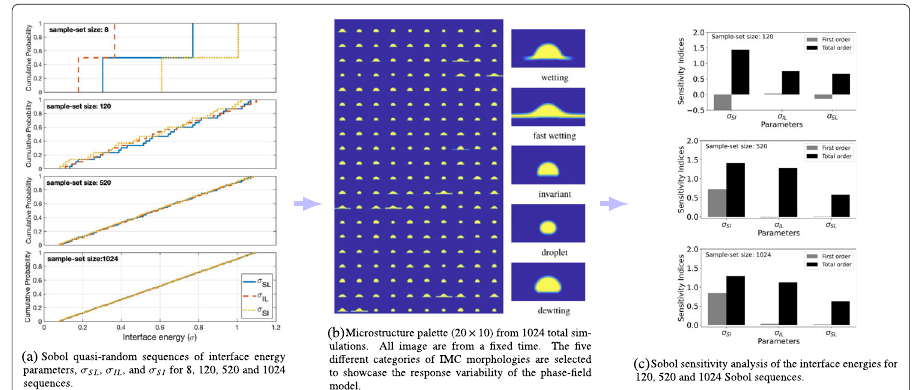
Fig. 5 The process of Sobol’ sampling, model forward run, and Sobol sensitivity